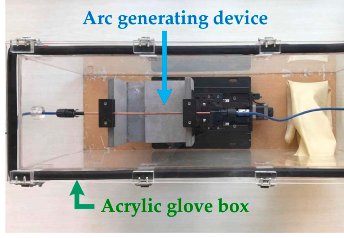
Figure 3. Arc generating platform. Table 1. Experiment conditions.